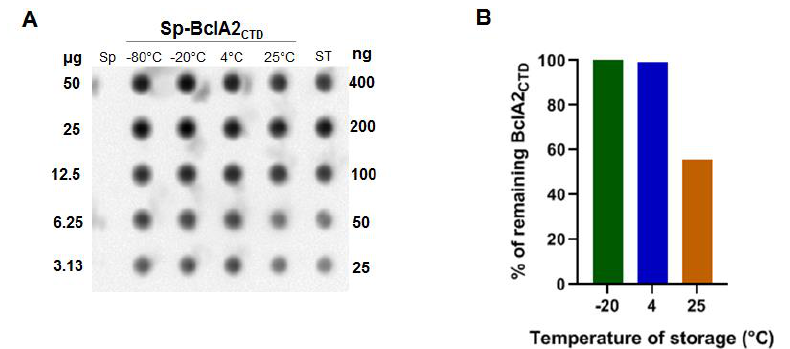
Figure 4. Stability of spore-adsorbed BclA2 CTD . ( A ) Dot blot of the protein extracted from spores adsorbed with BclA2 CTD stored for 2 d at −80, −20, +4, or +25 °C, using an anti-6xHis antibody. Proteins extracted from B. subtilis spores (sp) were used as negative control. Known amounts of the pure protein stored at −80 °C immediately after its purification (ST) were used as controls (right). ( B ) Plot of the densitometry analysis of dot blot experiment of panel A, considering the amount of protein extracted from spores stored at −80 °C as 100%.